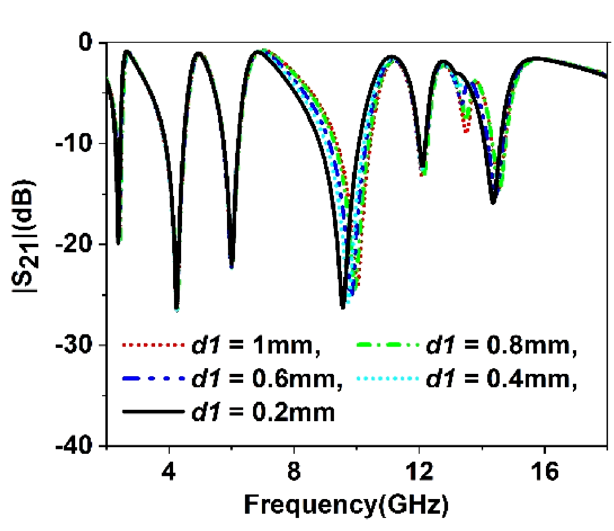
Figure 9. Study of variation of |S 21 | with outer ring split gap,